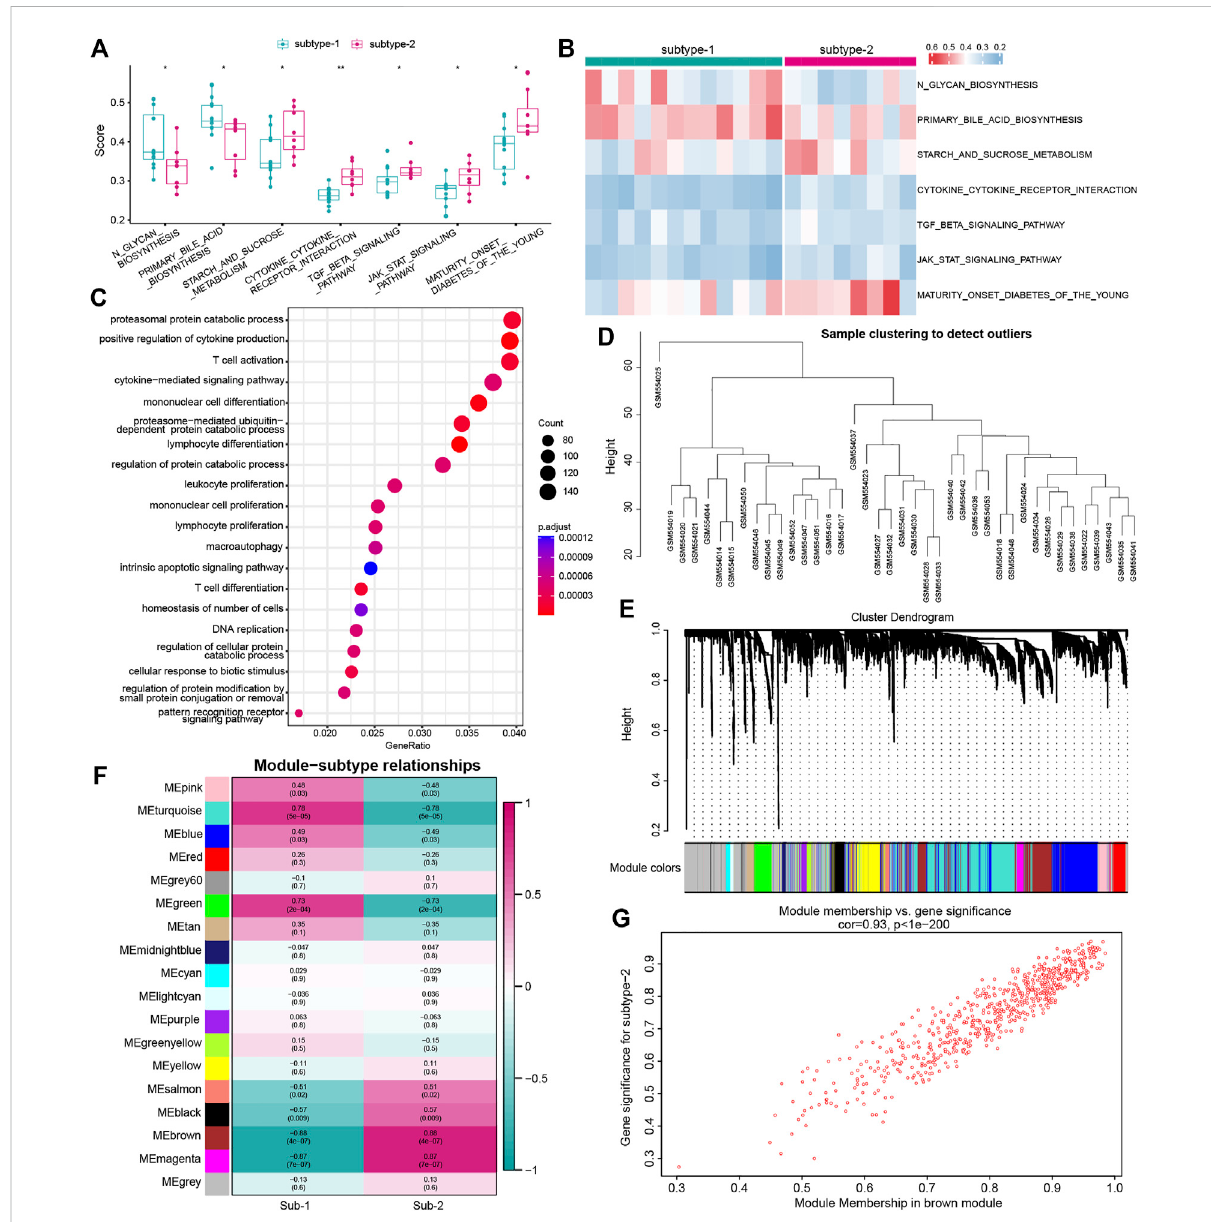
FIGURE 7 Underlying biological function characteristics of distinct autophagy expression subtypes. (A) Box plot showed the differences of the KEGG pathway enrichmentscore between subtype-1and subtype-2( p < 0.05). (B) Expression status of seven KEGG pathways insubtype-1 and subtype-2. (C) Top20ofGO-BPenrichmentanalysisofautophagyphenotype-relatedgenes. (D) Sampleclusteringwasperformedaccordingtotheexpression data on all samples. The top 25% of variation genes were used for the analysis by WGCNA. (E) Gene dendrogram obtained by average linkage hierarchical clustering. The color row underneath the dendrogram shows the module assignment determined by the Dynamic Tree Cut, in which 18 modules were identi fi ed. (F) Heatmap showed the correlation between module eigengenes and the two autophagy expression patterns. (G) Scatterplot of gene signi fi cance (GS) for subtype-2 versus the module membership (MM) in the brown module. GS and MM exhibit a very signi fi cant correlation, implying that hub genes of the brown module also tend to be highly correlated with